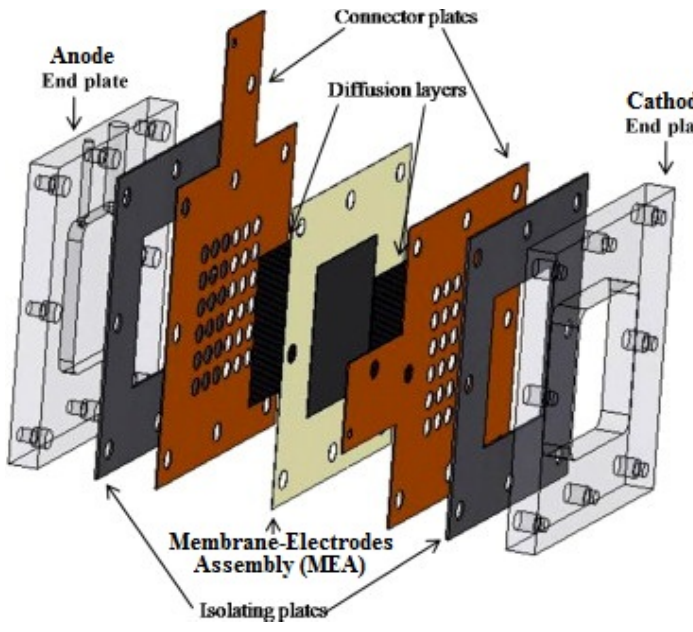
Figure 1. DAFC main components: exploded-view schematic.